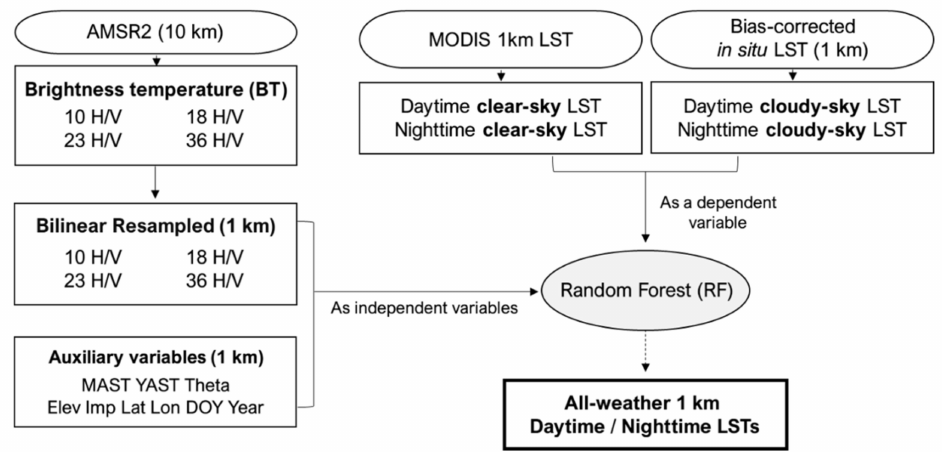
Figure 3. Flowchart of scheme 2(S2) for directly estimating 1 km all-weather LSTs in